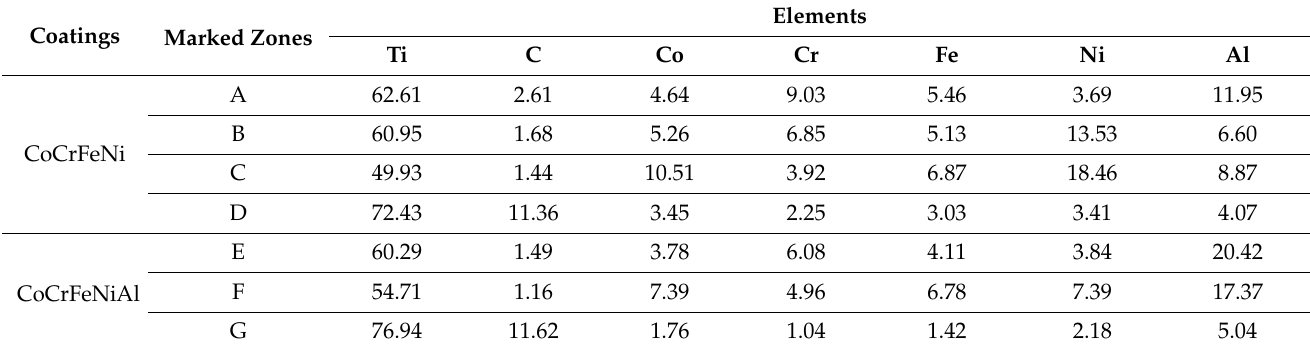
Table 2. EDS analyses of chemical compositions (at.%) for the marked zones are shown in Figure 5. Coatings Marked